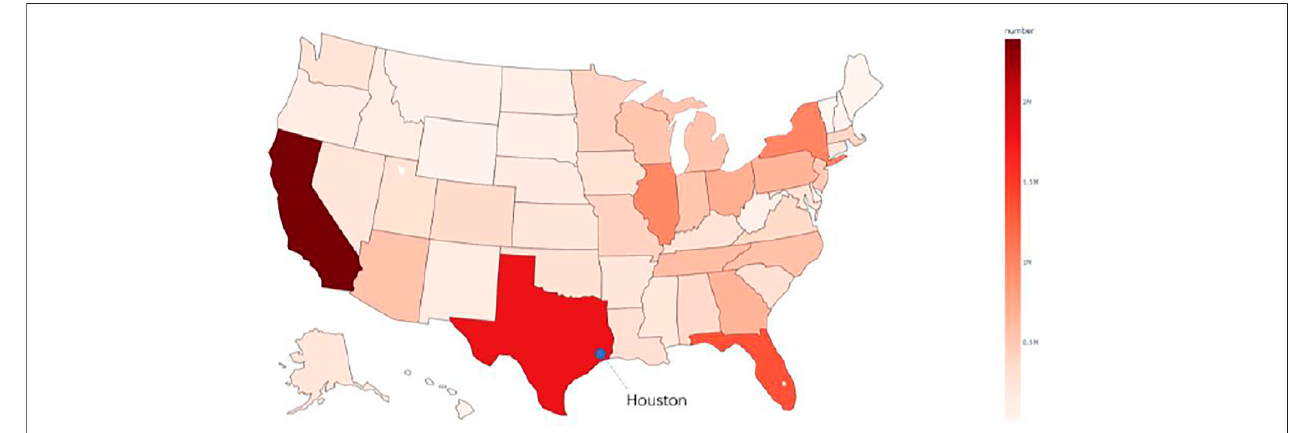
FIGURE 7 | Distribution of cumulative con fi rmed cases in the United States